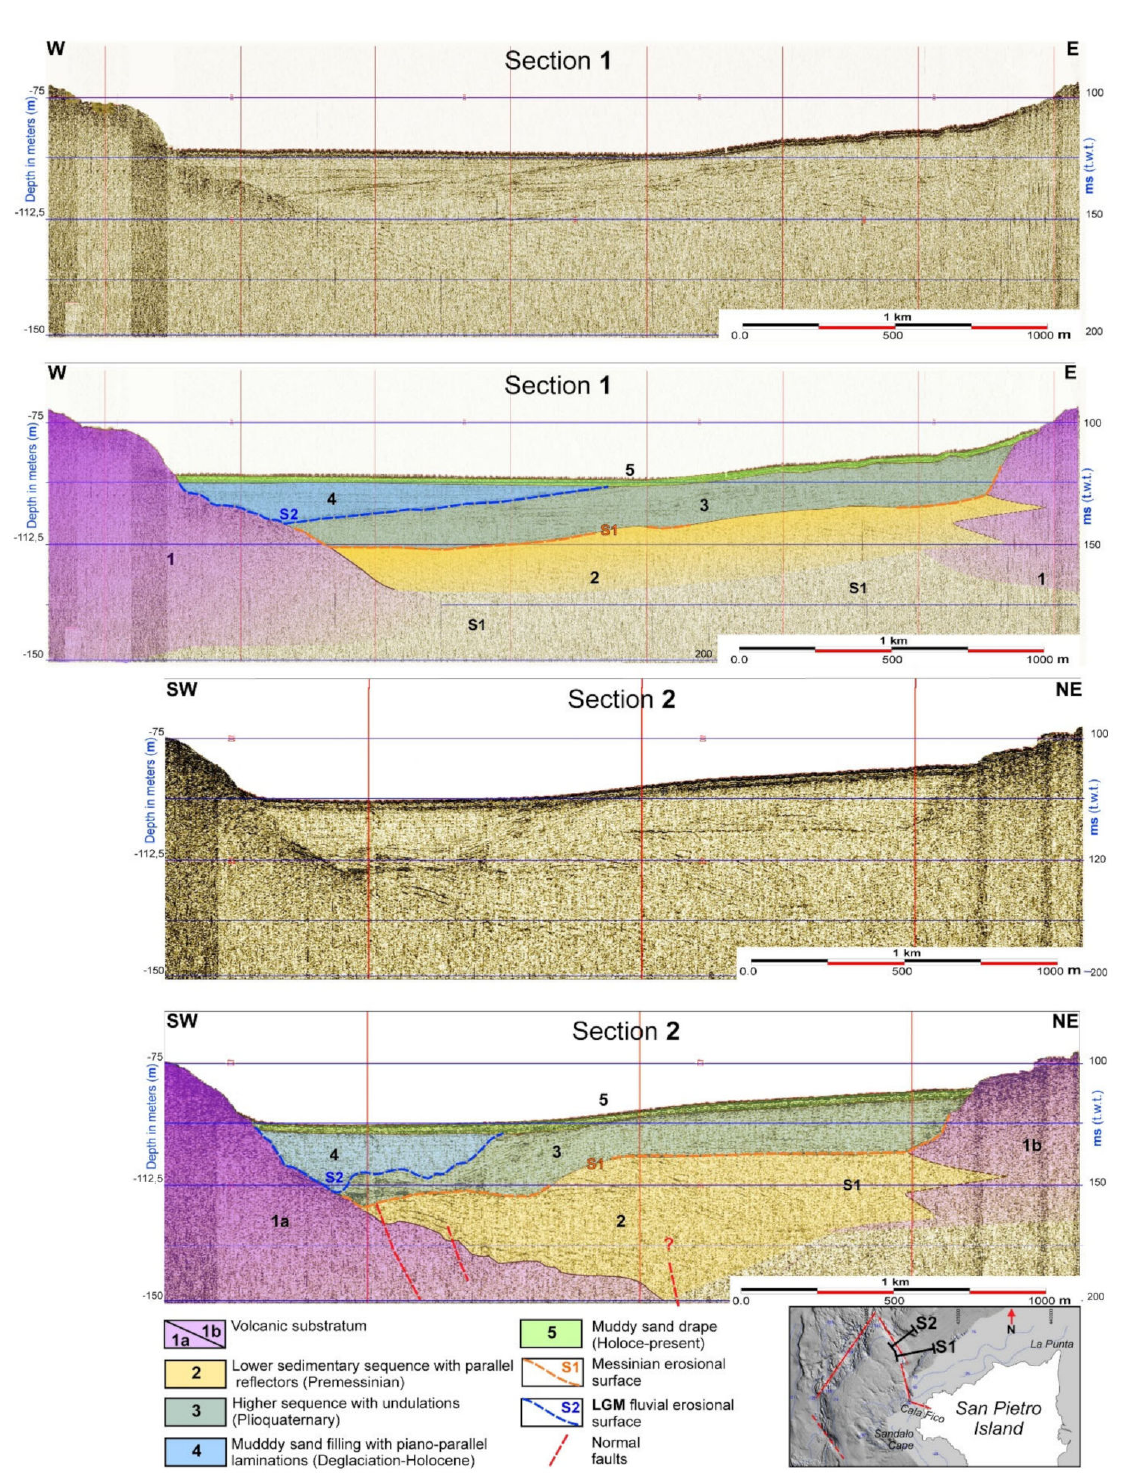
Figure 11. Seismic data of LGM